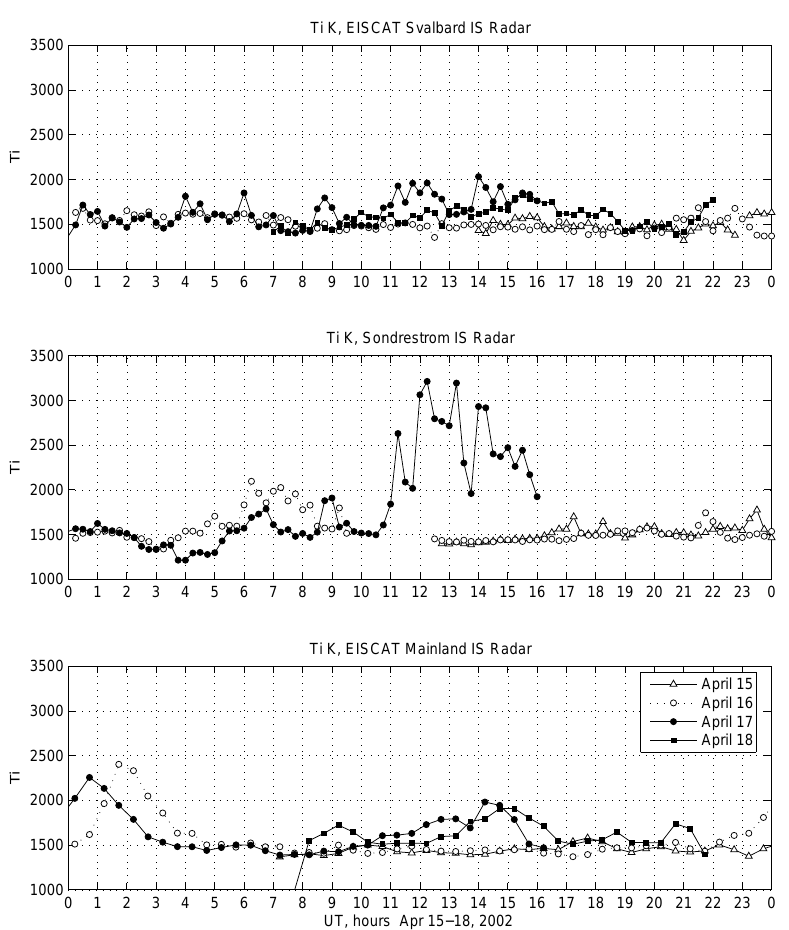
Fig. 6. Ion temperature at 350km measured by Svalbard ISR (top), Sondrestrom ISR (middle), and EISCAT Mainland ISR